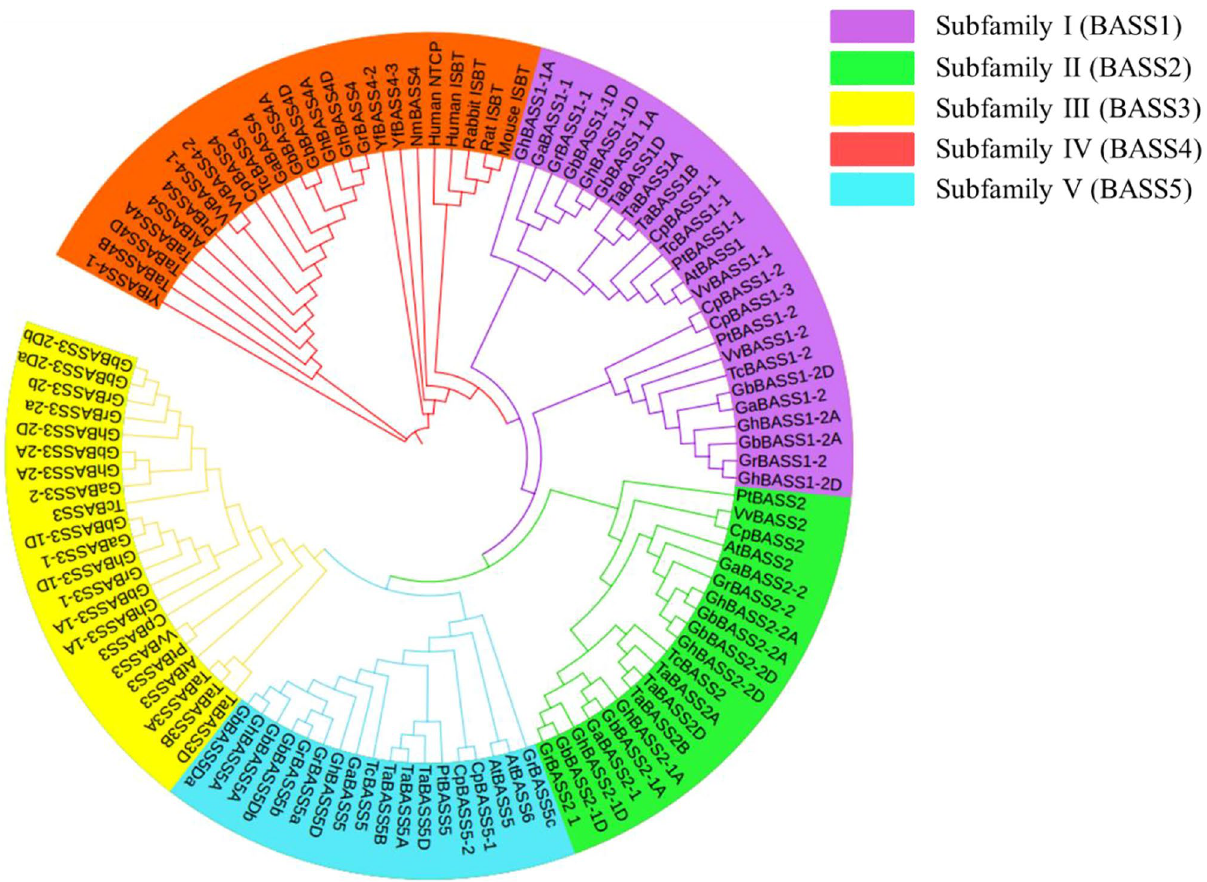
Figure 2. Phylogenetic tree of BASSs from plants, mammals and bacteria. The phylogenetic tree was constructed by employing the MAFFT program via the EMBL-EBI bioinformatics interface with default parameters, employing Gblocks to get conserved blocks, using PhyML to build the tree and visualizing the tree with the iTOL v4. Ga Gossypium arboretum , Gr Gossypium raimondii , Gh Gossypium hirsutum , Gb Gossypium barbadense , Os Oryza sativa , At Arabidopsis thaliana , Tc Theobroma cacao , Vv Vitis vinifera , Pt Populus trichocarpa , Ta Triticum aestivum , Cp Carica papaya , Yf Yersinia frederiksenii , Nm Neisseria meningitides , NTCP Sodium-taurocholate co-transporting polypeptide, ISBT Ileal sodium bile acid intron, in which GbBASS1-2D carried the shortest genomic sequence (1145 bp) bearing 5 exons, leading to vari- ation in the gene length of that group. The majority of participants in the BASS2 clade were comparatively less